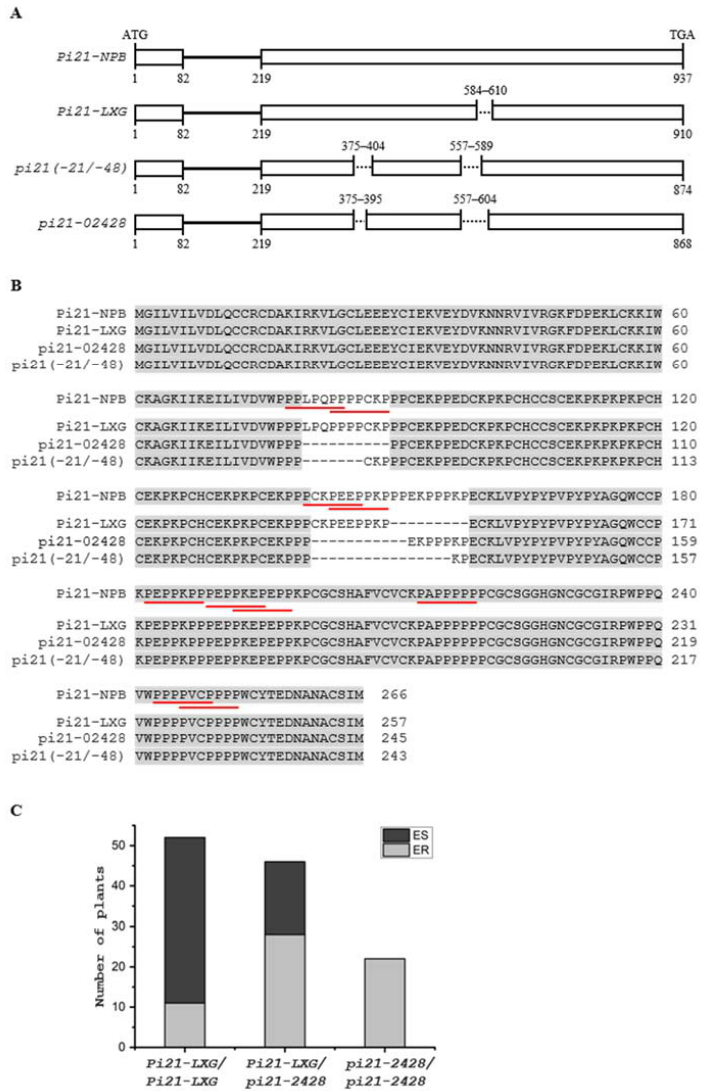
Figure 4. Identification of a novel haplotype of pi21 as a candidate gene of qBBR ‐ 4 . ( A ) Schematic diagram of the genomic coding region of the Pi21 alleles in Nipponbare ( Pi21 ‐ NPB ), LXG ( Pi21 ‐ LXG ), and 02428 ( pi21 ‐ 2428 ), and the resistant allele of haplotype L containing double deletions of 21 bp and 48 bp ( pi21( ‐ 21/ ‐ 48) ) [16]. Open boxes represent exons, lines represent introns, and dotted lines represent deletions. Numbers above the diagrams indicate positions of deletions corresponding to the Pi21 ‐ NPB allele, and numbers below the diagrams represent the start and end nucleotide positions of exons of each allele. ( B ) Alignment of the deduced amino acid sequences of Pi21 ‐ NPB, Pi21 ‐ LXG, pi21 ‐ 2428, and pi21( ‐ 21/ ‐ 48). Putative proline ‐ rich motifs (PxxPxxP) for protein–protein interaction are underlined in red. ( C ) Genotype ‐ phenotype correlation analysis of 61 ER individuals and 59 ES individuals. All the homozygous pi21 ‐ 2428 individuals belonged to the ER bulk.